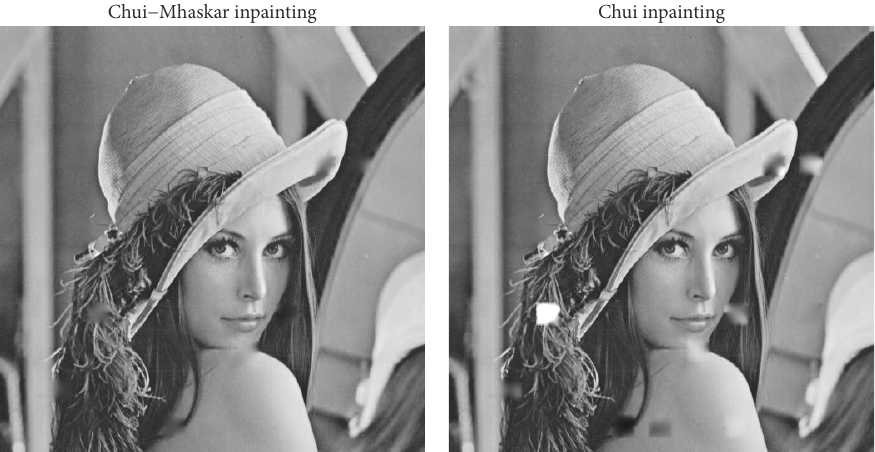
Figure 6: Restored image by biharmonic